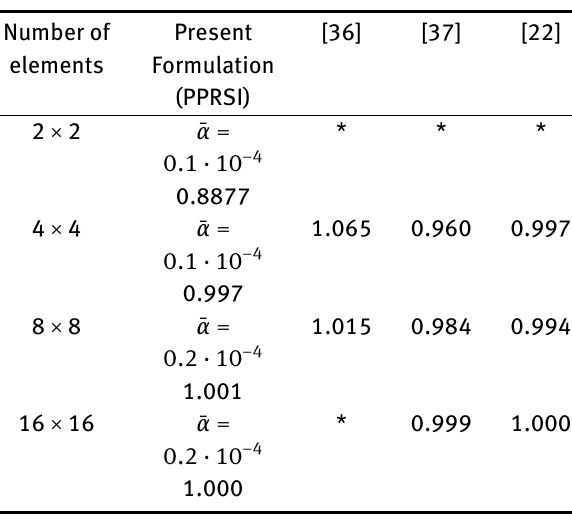
Table 3: Comparison of FE solutions, using four-node element, for vertical displacement under the uniform vertical gravity load: finite element solution and PPRSI vs. exact